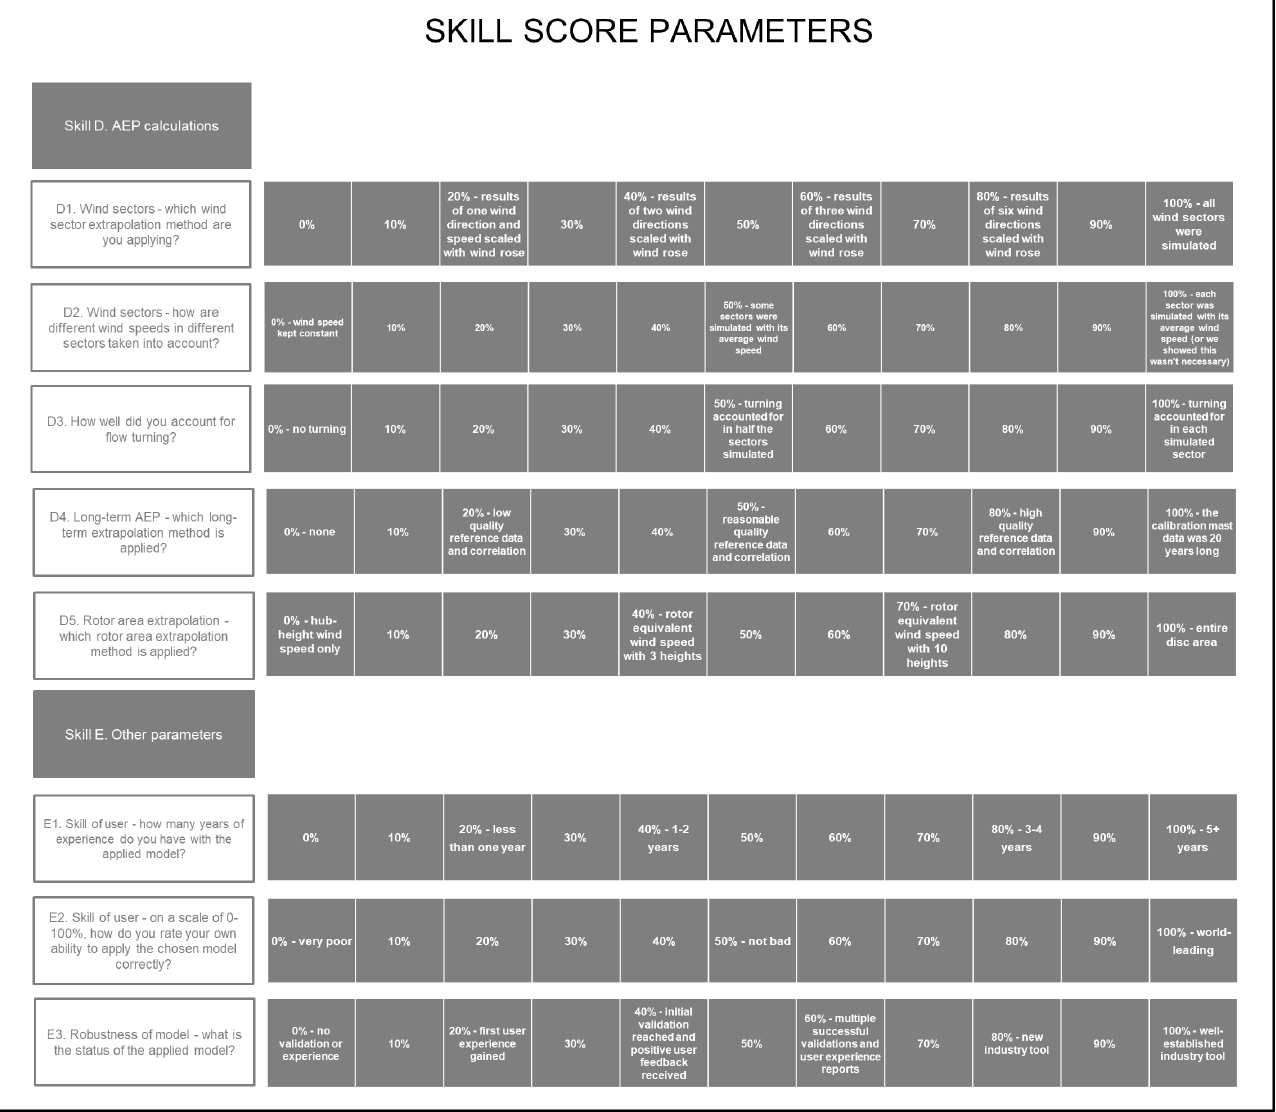
Figure A3. Scales assigned to each skill parameter (Skills D and E).